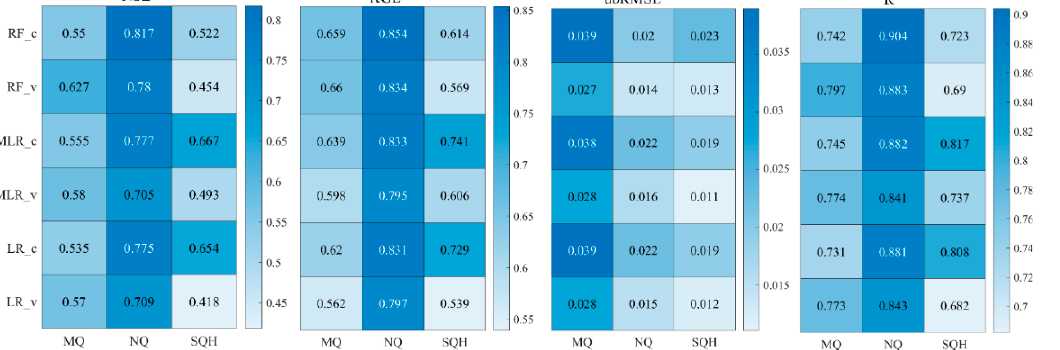
Figure 6. Heat map of statistical scores, including the Nash-Sutcliffe efficiency coefficient (NSE), Kling–Gupta efficiency (KGE), unbiased root mean square error (ubRMSE), and correlation coefficient (R), based on the fits by RF, MLR, and LR in MQ, NQ, and SQH. The subscripts c and v indicate the calibration and validation data sets, respectively.